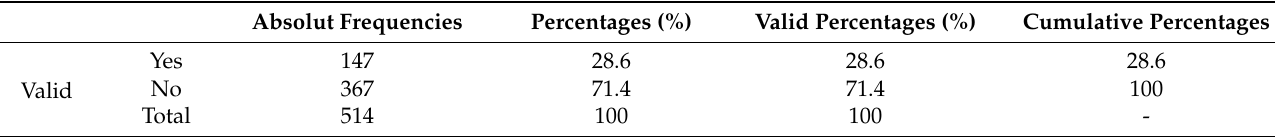
Table 4. The intention of using technology for health needs.